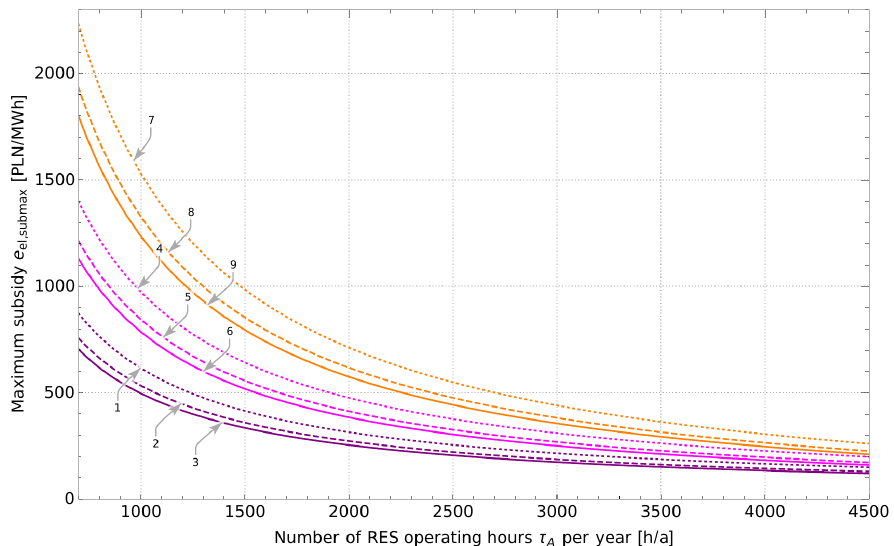
Figure 8. Maximum subsidy e el,submax as a function of time τ A , (1— N RES